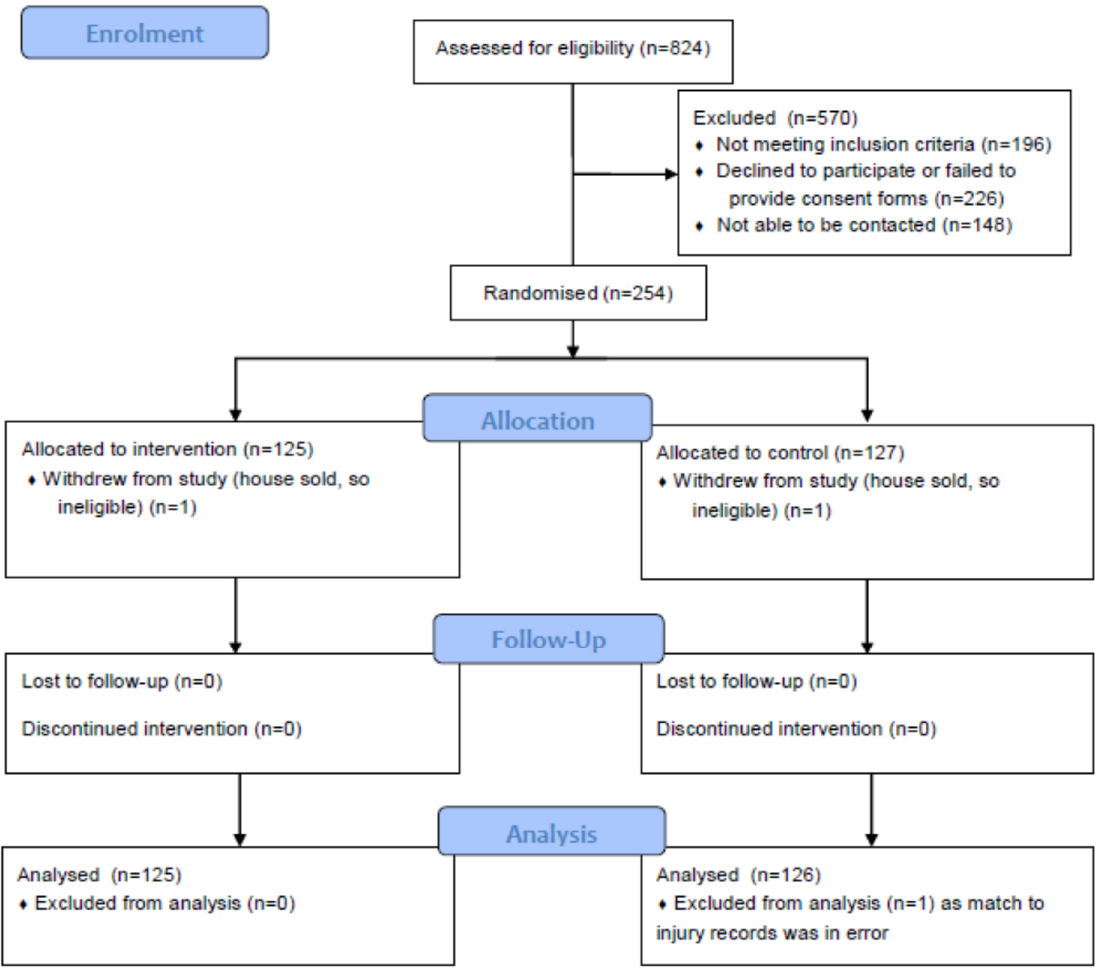
Figure 1. Flow diagram of participant numbers (households) according to CONSORT 2010 [8].